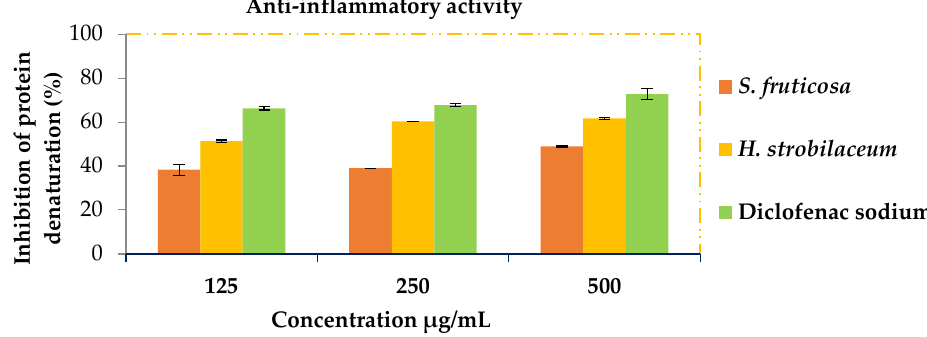
Figure 2. The anti-inflammatory activity of H. strobilaceum , S. fruticosa and the positive control (Diclofenac sodium) (125, 250, and 500 µg/mL).